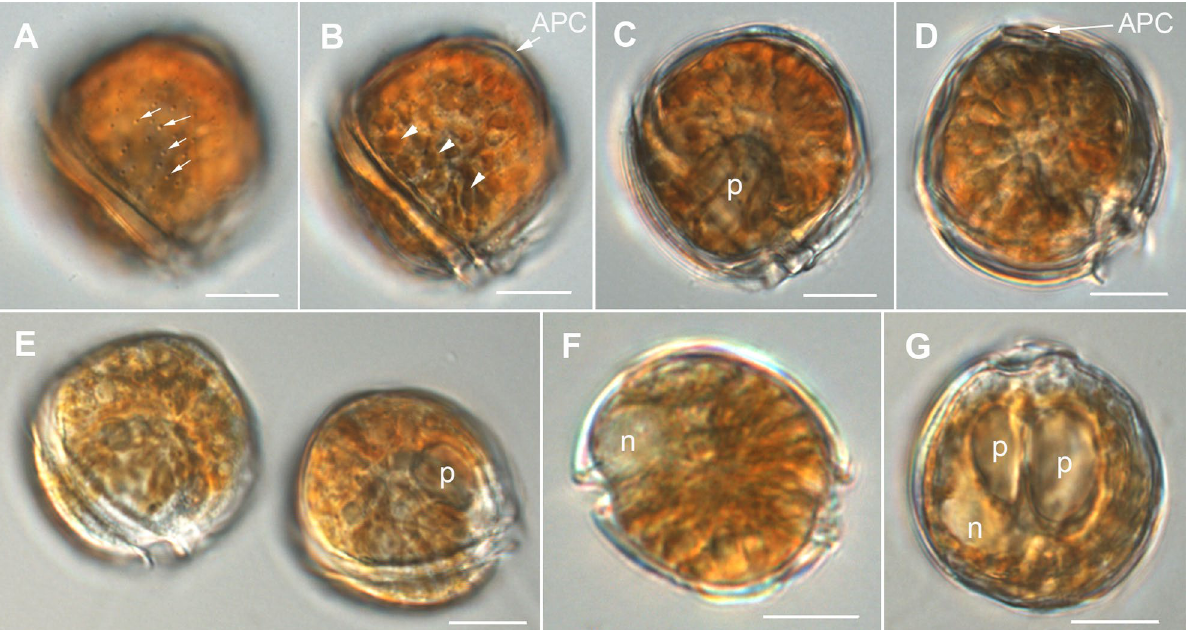
Figure 9. Light micrographs of Coolia malayensis strain C6C1 showing the cell shape and general features. ( A–C ) Same cell in different focal planes. Globular cell, ventrally slightly tapering and containing chloroplasts. ( A ) Surface focus on the epitheca showing thecal pores (arrows). ( B ) The slit-like apical pore complex (APC) can be recognized; chloroplasts are distinguishable (arrowheads). ( C ) Mid cell focus showing the pusule (p). ( D ) Apical view showing the APC in dorsal left position. ( E ) Two specimens in different views demonstrating the spherical cell shape. Note the pusule (p) in the right cell. ( F ) Right lateral view, mid cell focus. The nucleus (n) is located dorsally in the episome. ( G ) Cell in apical or antapical view in mid cell focus showing the nucleus (n) and two pusules (p). Scale bars = 10